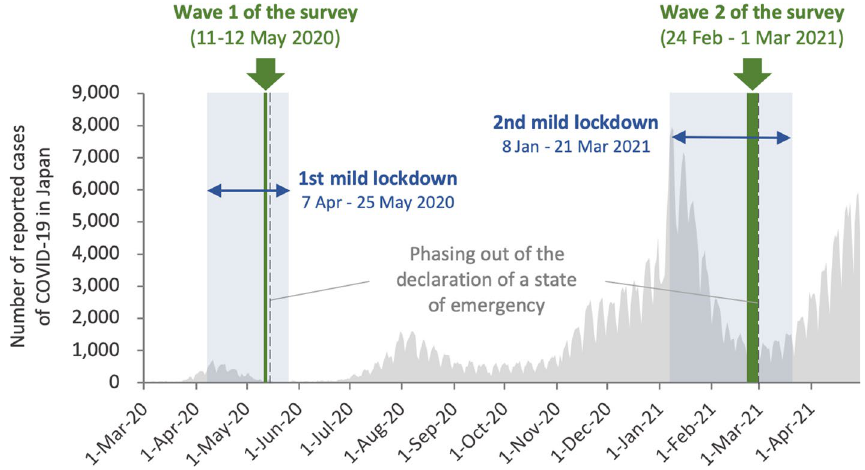
Figure 1. Status of COVID-19 infection in Japan from March 2020 to April 2021 and the study